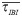
Statistical analysis of the effects of [Mg2+] on properties of SBs for early and late DIVs.The firing rate (f), inter-burst interval (τIBI¯) and the number of sub-burst measured with different [Mg2+] concentrations for old (a1:a3, DIV>15, N = 9, bursts = 395 and 967 in 0.8 mM and 0 mM [Mg2+]) and young (b1:b3, DIV<15, n = 3) cultures. P<0.05 (*); P<0.005 (***).